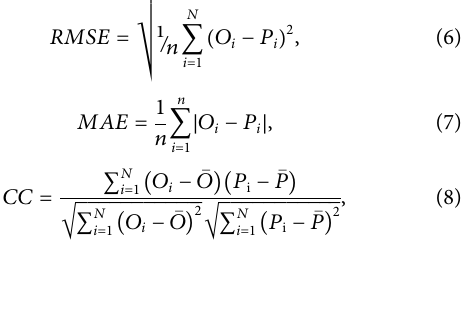
(MAEand RMSE) wereusedtoevaluatethe errorinthe models, and two (CC and WI) were utilized to assess the models ’ ability to simulate the temporal pattern of observed DO. They are de fi ned as: